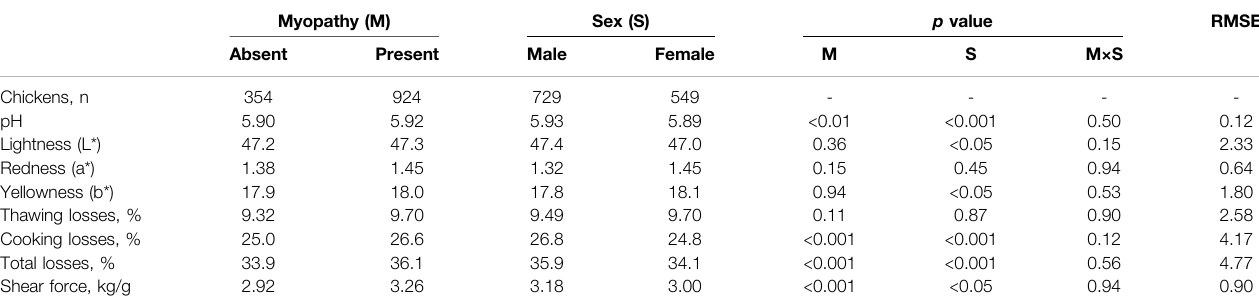
TABLE 7 | Effect of myopathy presence, sex and their interactions on breast quality traits. Myopathy (M) Sex